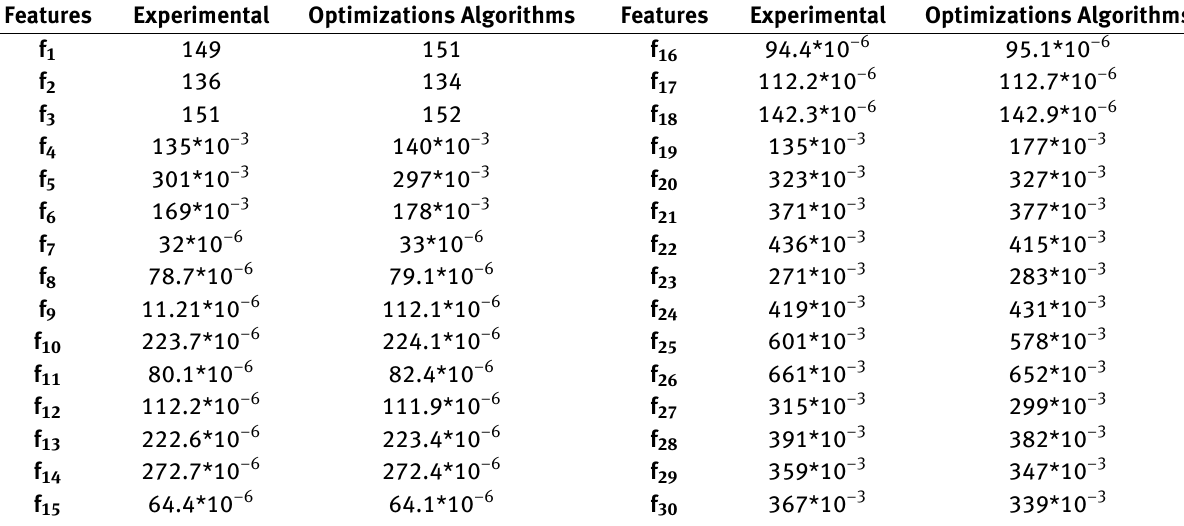
Table 3: The optimization algorithm’s results reflected GA for the multi X-crossover operator Features Experimental Optimizations Algorithms Features Experimental Optimizations